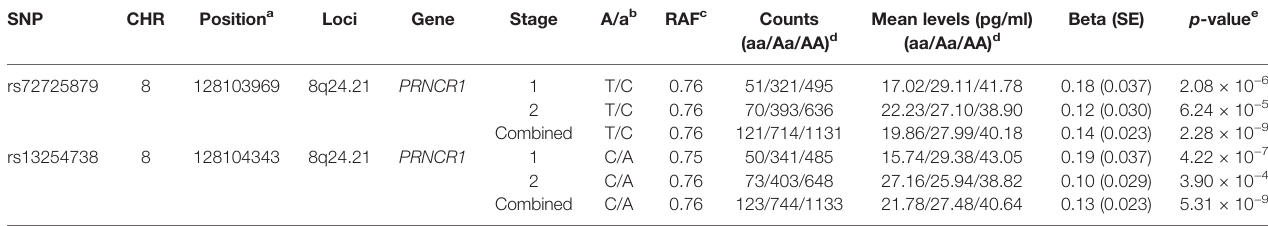
TABLE 2 | Results of genome-wide association study (GWAS) for logp2PSA in the cohort. SNP CHR Position a Loci Gene Stage A/a b RAF c Counts